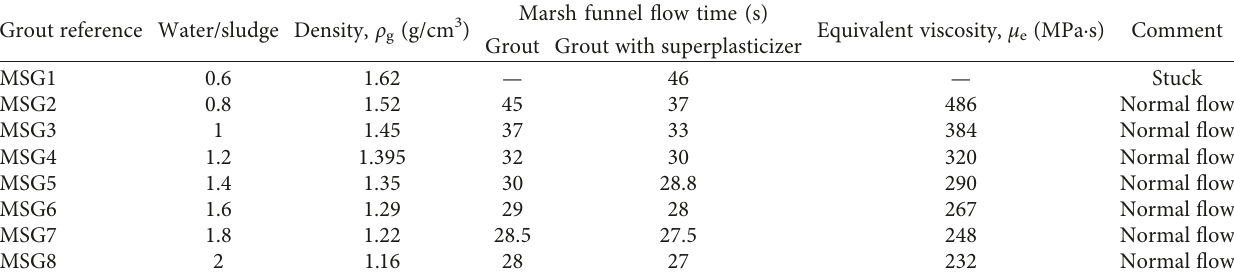
Table 9: Marsh funnel flow time and equivalent viscosity of different